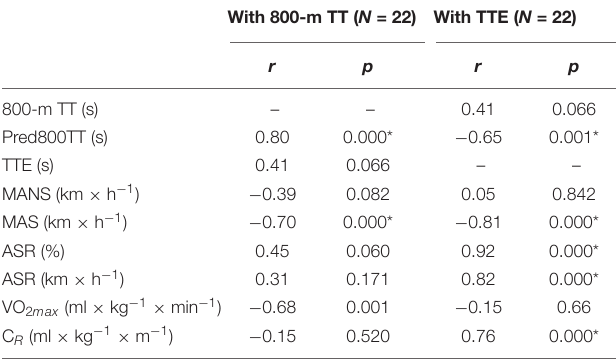
TABLE 3 | Correlations with 800TT and TTE, independent of gender. Correlations with 800-m TT